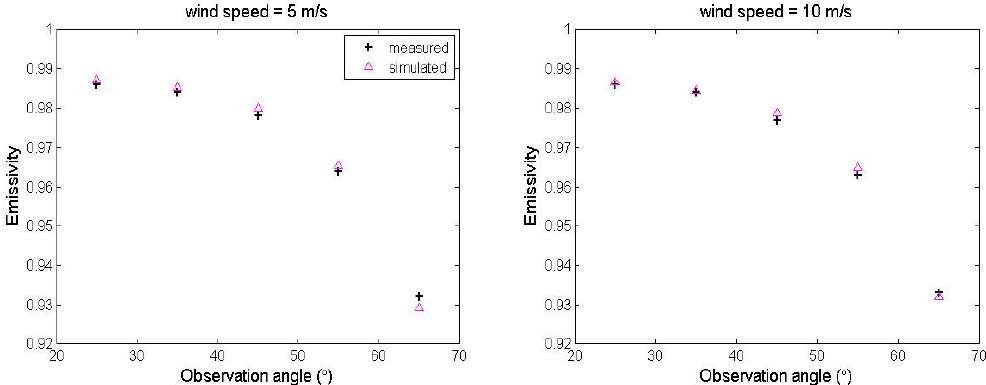
Figure 6. Comparison between the measured and simulated directional BBE values at 8–14 μ m.